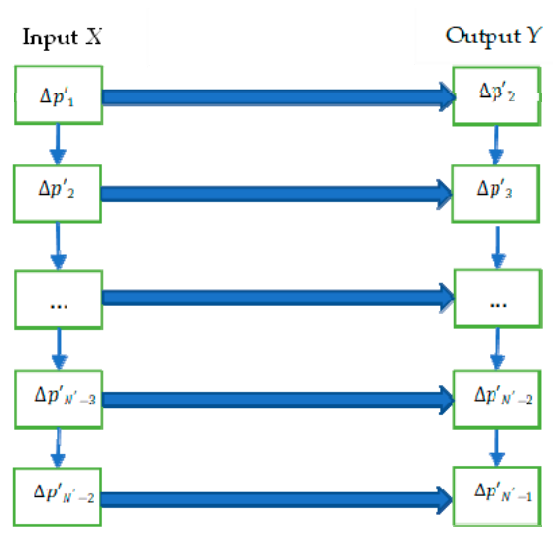
Figure 2. The semantic feature mapping process.